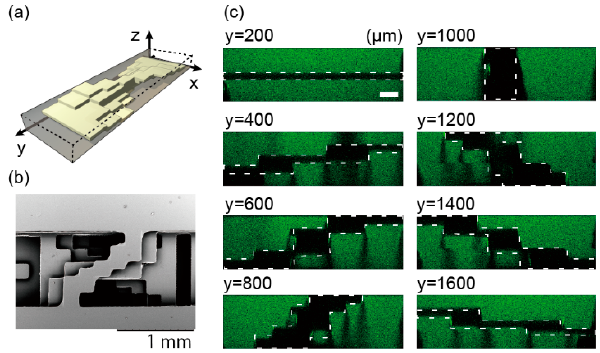
Figure 3. Diagrams of a spiral structure. ( a ) A conceptual image of the structure. ( b ) A SEM image of the structure from top-down view. ( c ) Confocal images of vertical cross sections at every 200 µm in the flow direction of the microchannel filled with fluorescein solution. White dotted lines represent cross-sectional shapes of a five-layer structure. Scale bar is 100 µm.